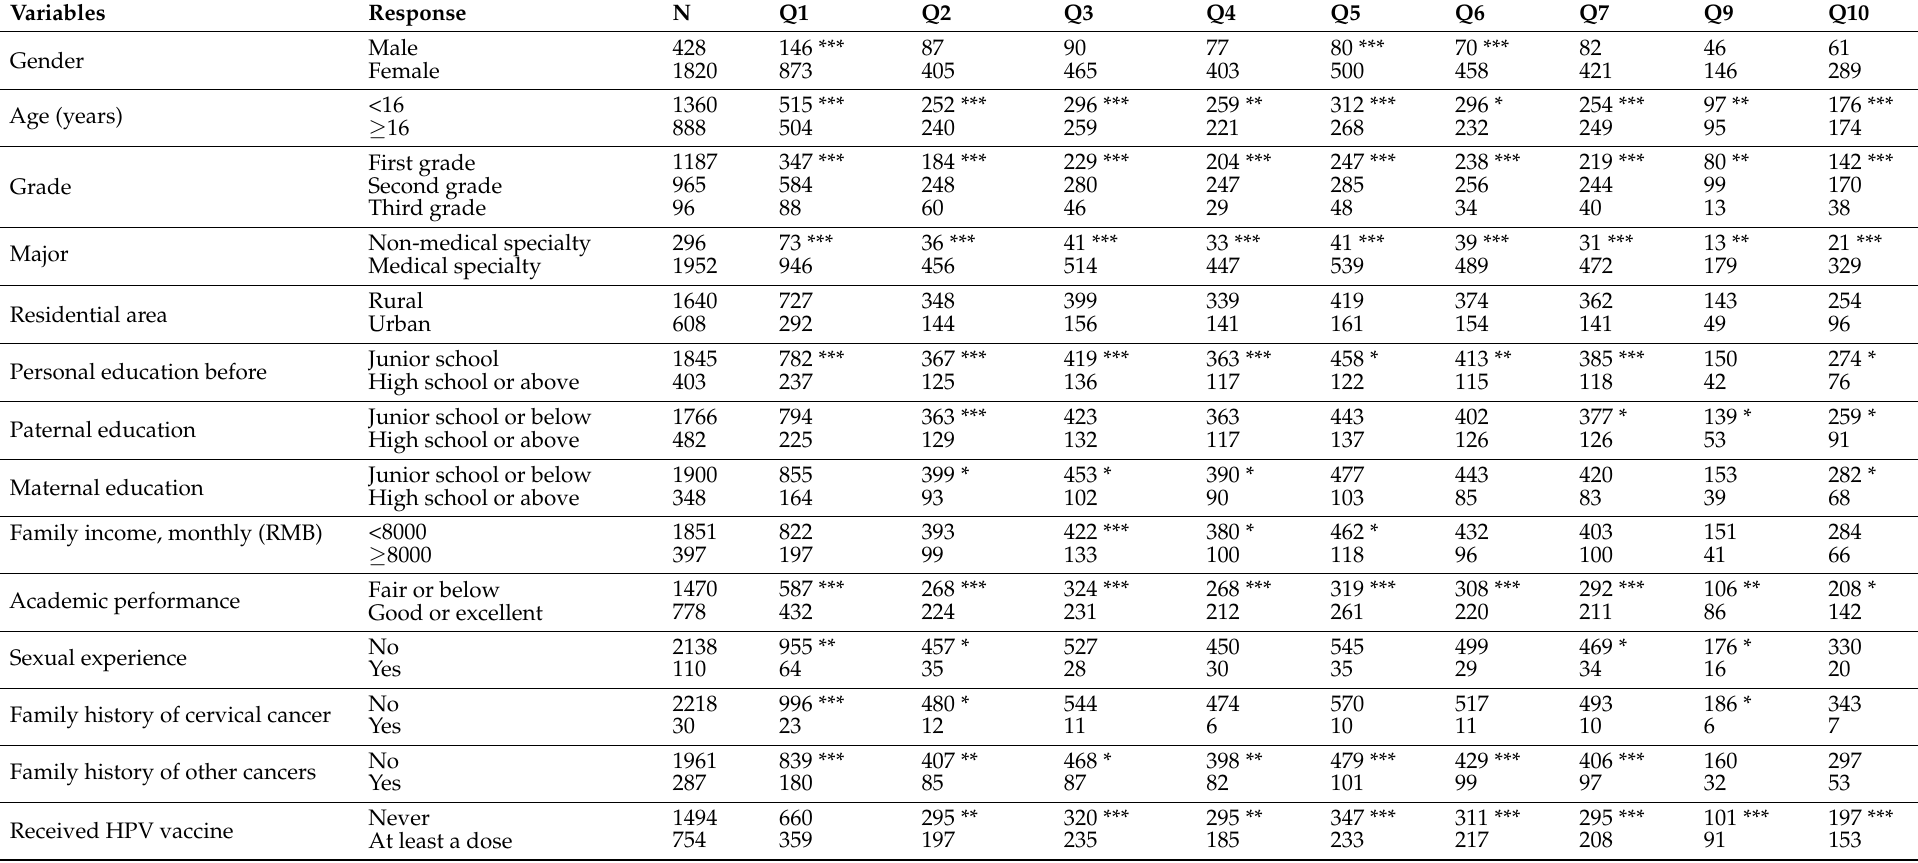
Table 3. The participants’ positive answers to some items of HPV infection stratified by characteristics (chi-square